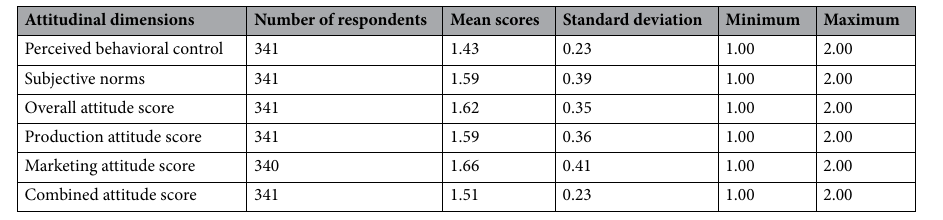
Table 1. Descriptive statistics of the attitudinal